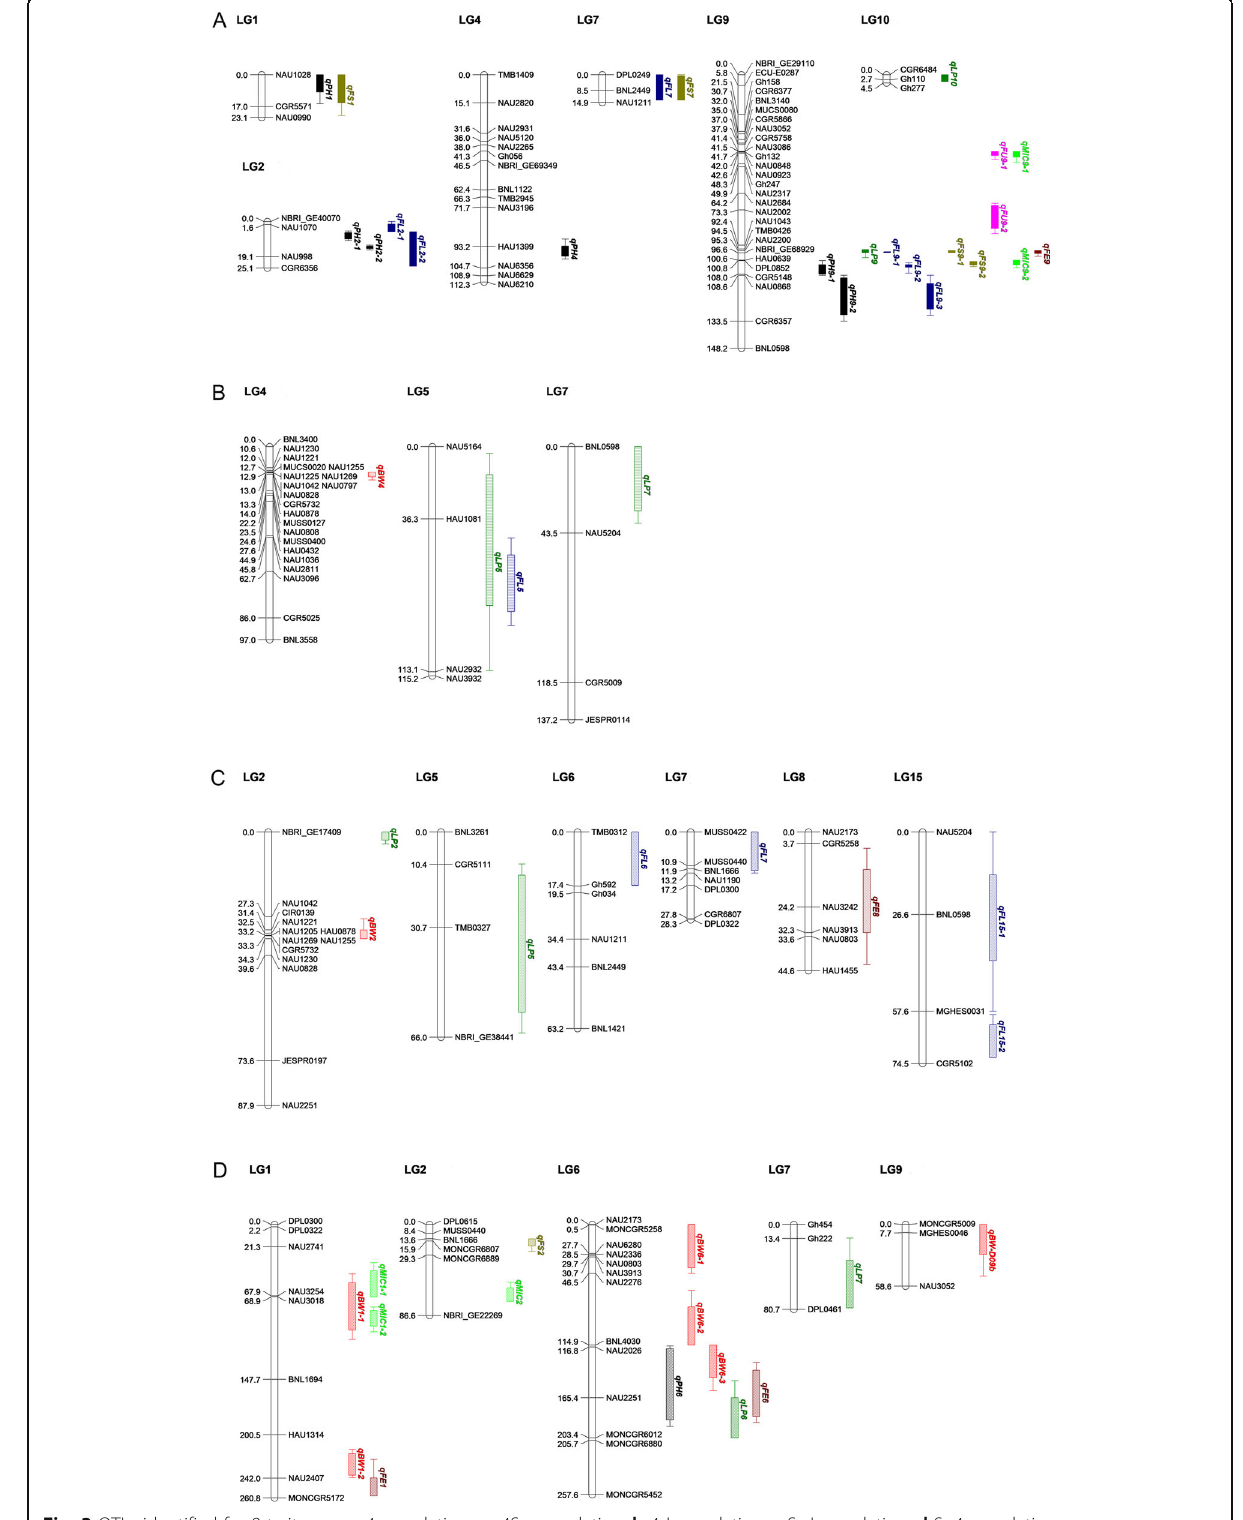
Fig. 3 QTLs identified for 8 traits across 4 populations. a 4Su population; b 4 J population; c SgJ population; d Sg4